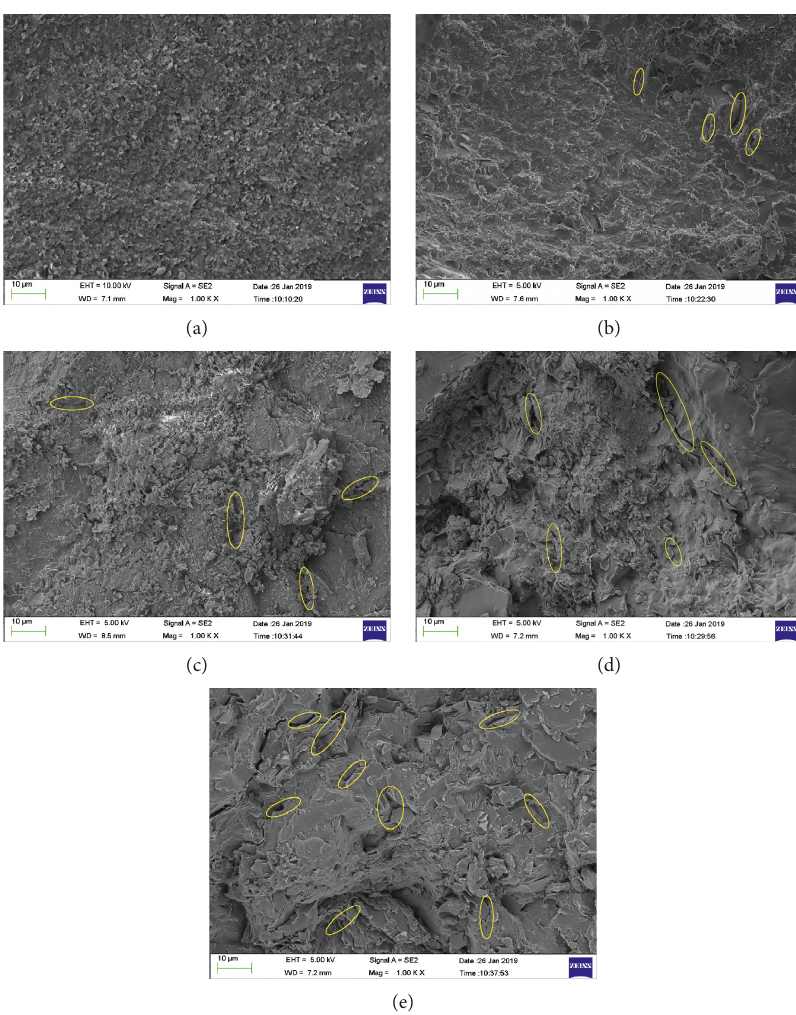
Figure 14: SEM images of the sandstone specimen after different wetting and drying cycles. (a) 0. (b) 5. (c) 10. (d) 15. (e)